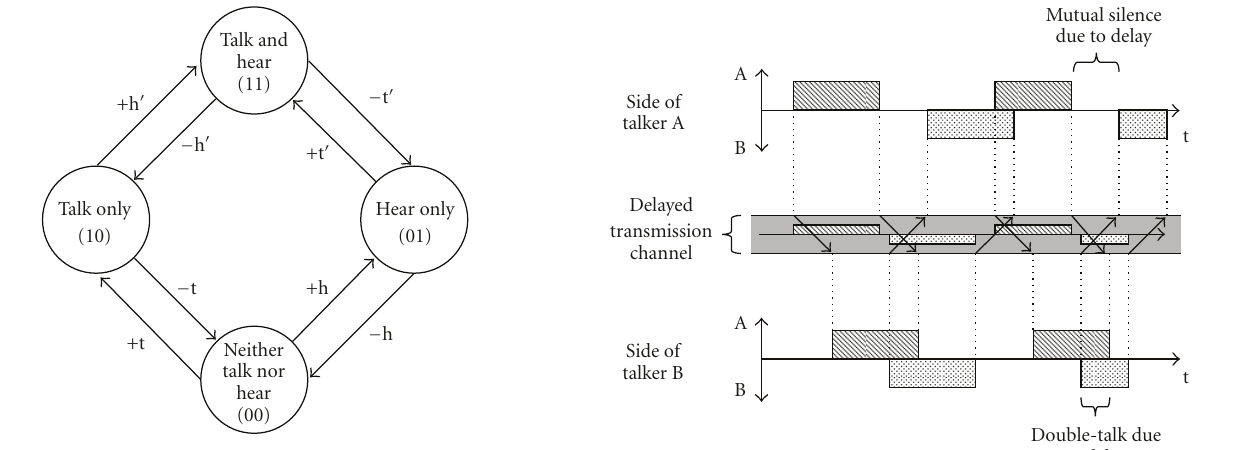
Figure 1: States and events in conversation as perceived by one participant [12]. Figure 2: Impact of the delay on conversation